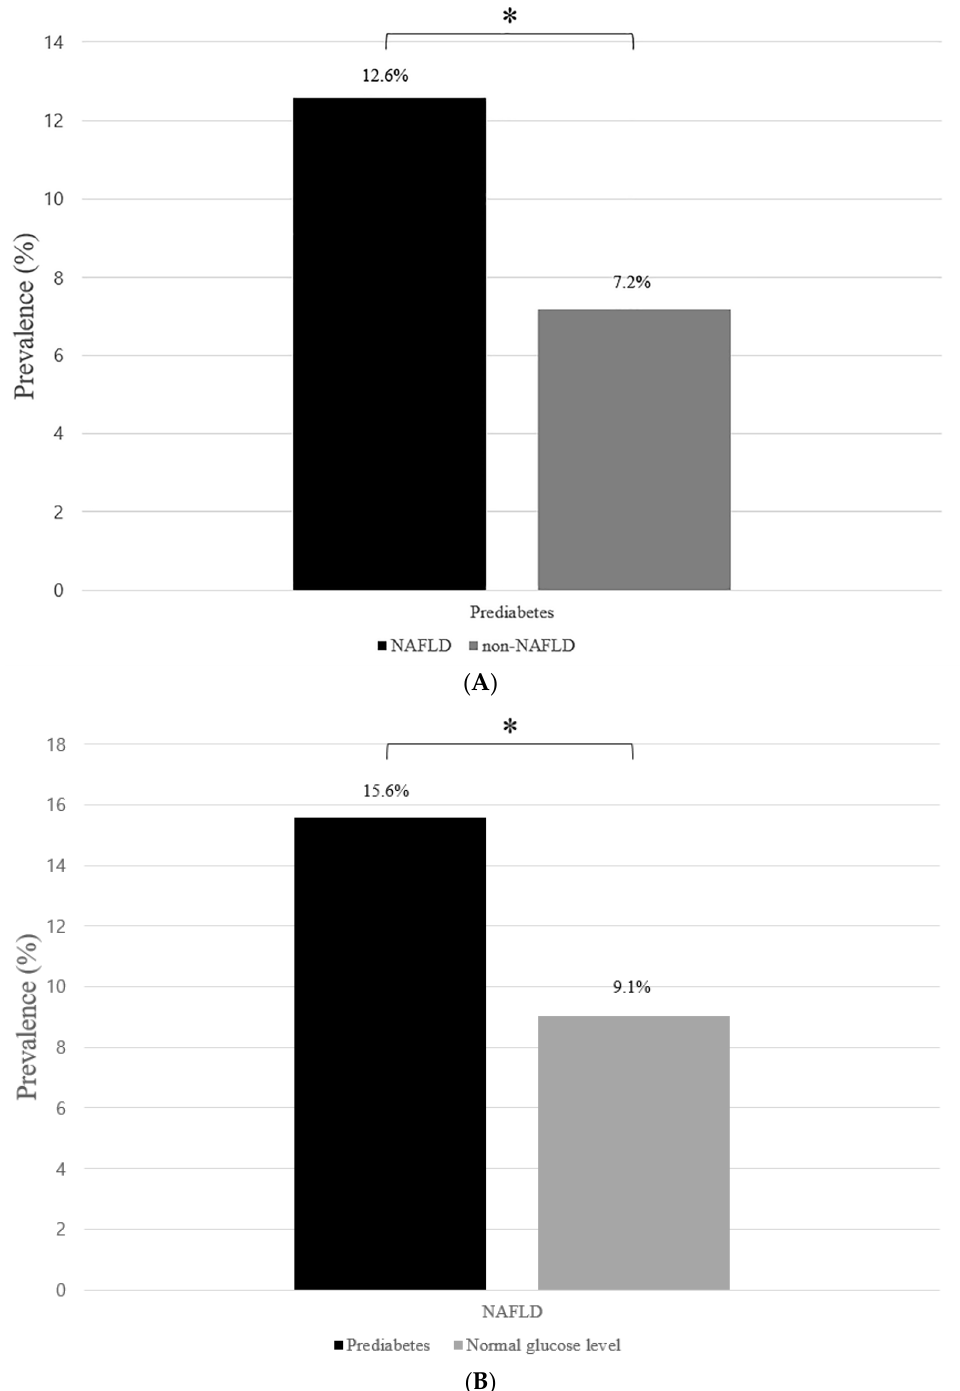
Figure 3. Prevalence of prediabetes according to NAFLD and those of NAFLD according to predia- betes. ( A ) Prevalence of participants with prediabetes among those with NAFLD and non-NAFLD. The “black” bar represents the NAFLD group, whereas the “gray” bar represents the non-NAFLD group. ( B ) Prevalence of participants with NAFLD among those with prediabetes and normal glucose levels. The “black” bar represents the prediabetes group, whereas the “gray” bar represents the normal glucose group. The asterisk indicates the p -value of the independent two-sample t -test < 0.01. NAFLD: non-alcoholic fatty liver disease